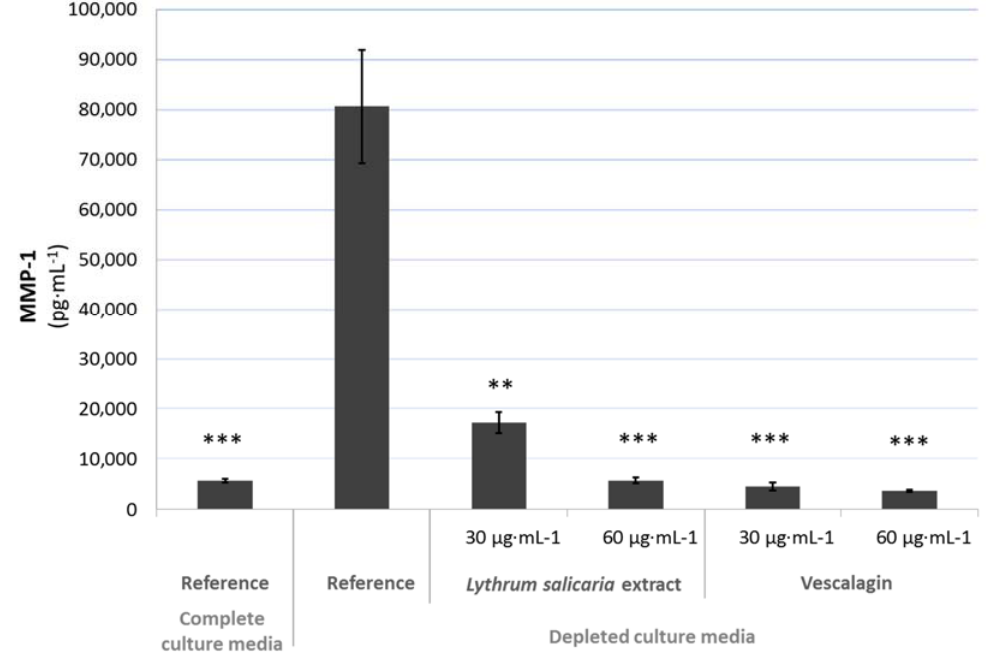
Figure 6. Effect of Lyth. s . extract and vescalagin on expression of MMP-1 in full thickness reconstructed skin (FTSK) monitored by ELISA quantification in cell culture subnatants of FTSK. Statistical analysis was performed versus the Reference condition. Statistical significances; ns: non-significant ( p > 0.05), *: significant (0.01 < p < 0.05), **: very significant (0.001 < p < 0.01), ***: extremely significant ( p < 0.001)).